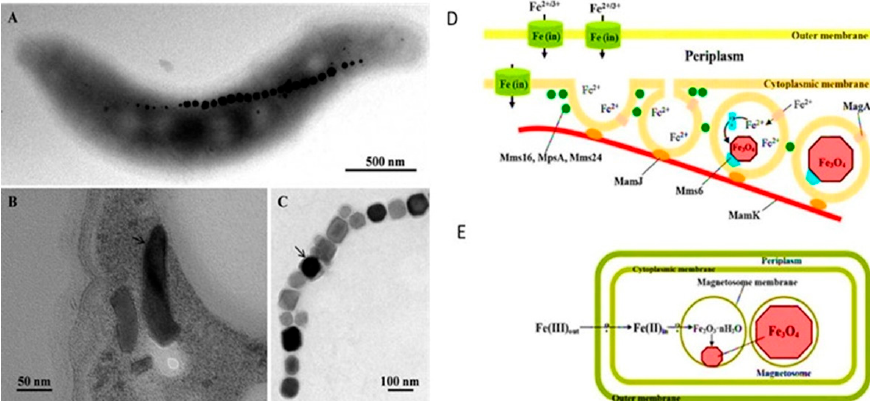
Figure 5. Transmission electron microscope (TEM) images of magnetosomes and the magnetosome membrane. ( A ) TEM micrograph of a cell of Magnetospirillum magneticum strain AMB-1 deposited